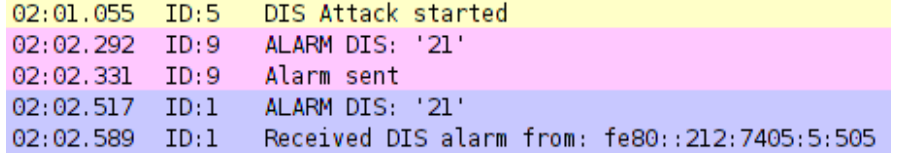
Figure 7. DIS attack log showing